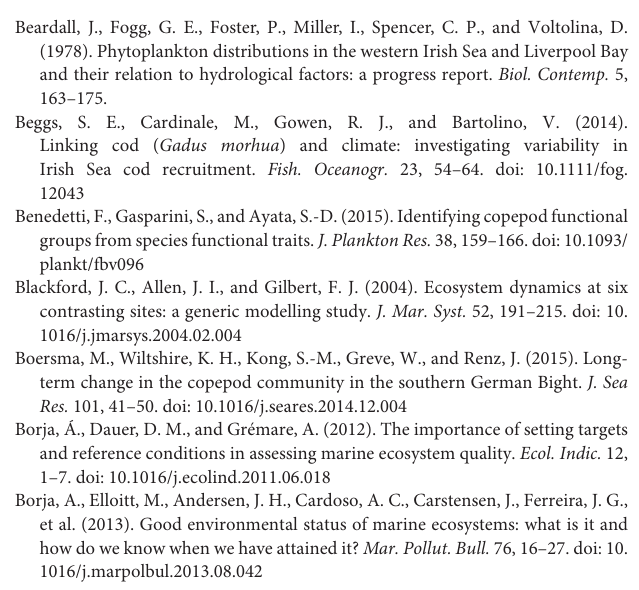
Figure 7 and to Mr. Brian Stewart for the collection and analysis of AFBI’s unpublished